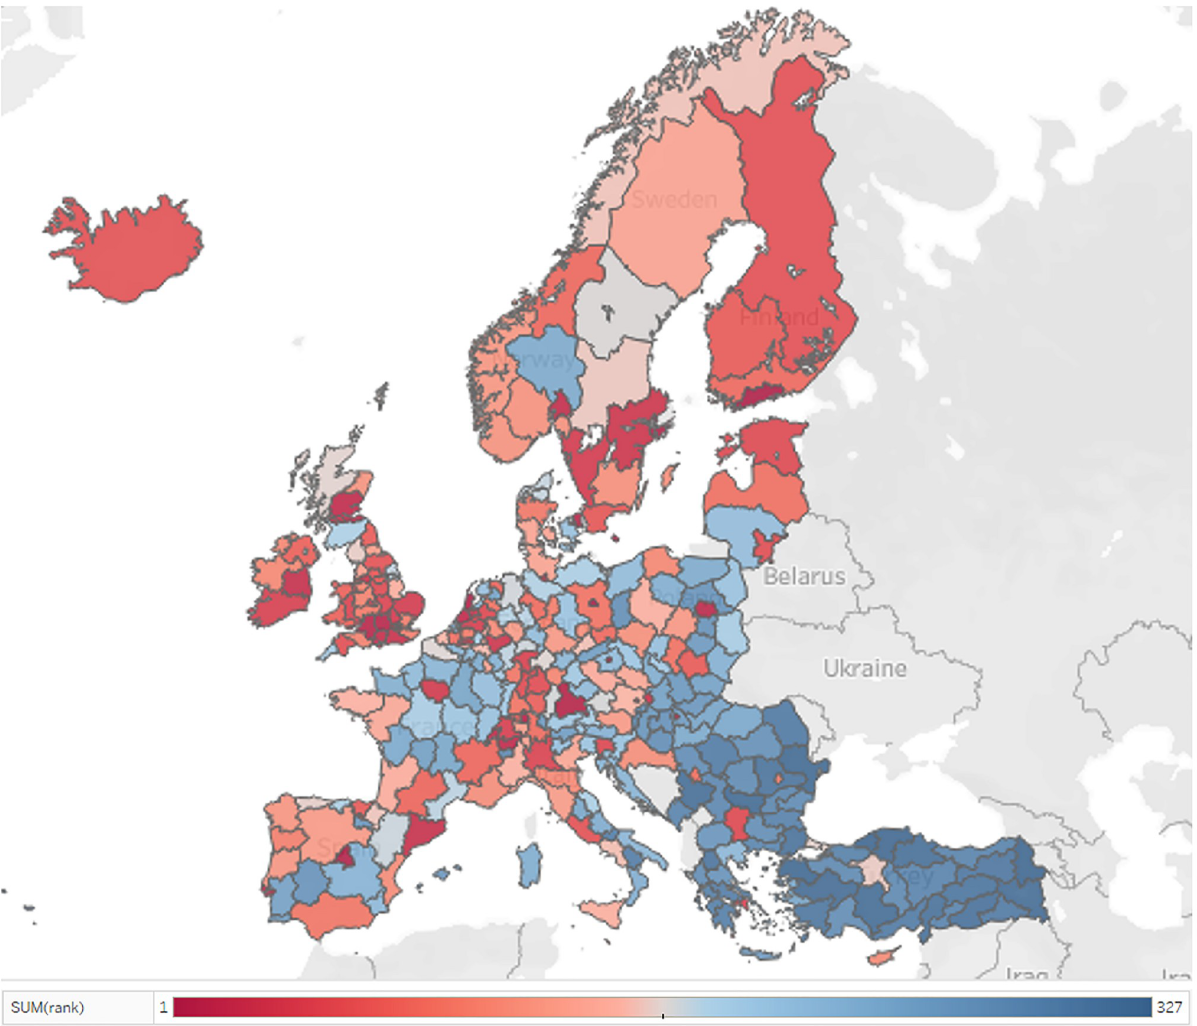
Fig 7. European NUTS 2 regional I4.0 readiness ranking based on the Promethee method